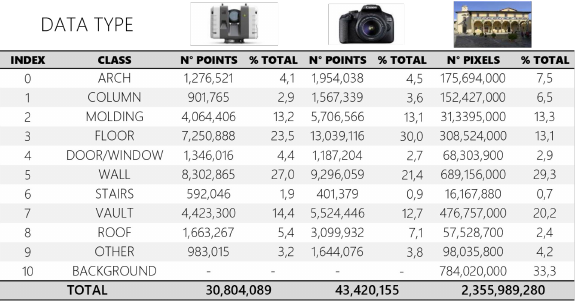
Table 1 . Summary of the number of points and pixels of the current